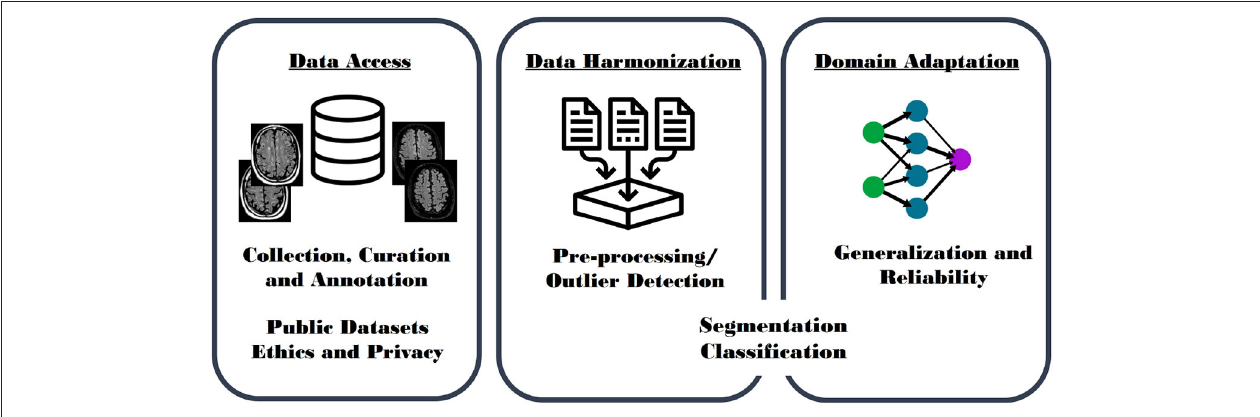
FIGURE 1 | Graphical paper outline. Data Access (left): including description of heterogeneous datasets due to variations in acquisition, curation, and annotation; challenges with access to publicly available data, and issues relating to ethics and privacy concerns. Data Harmonization (middle): including model development from standardized image sets generated by performing pre-processing and outlier detection algorithms. Domain Adaptation (right): including use of advanced techniques and models that improve generalization and reliability by using techniques, such as domain transfer and multi-task learning, as well as adversarial network approaches. Data Harmonization and Domain Adaptation are further organized by proposed task: segmentation and classification